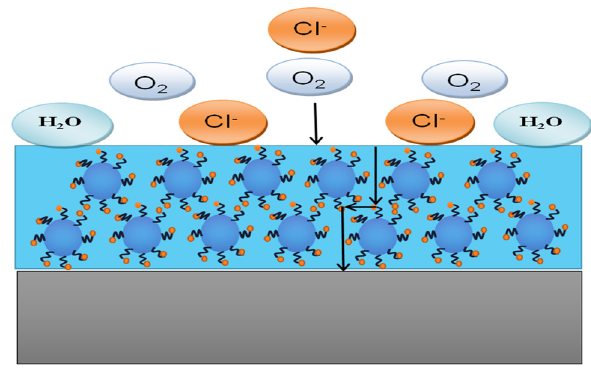
Figure 12: Corrosion protection